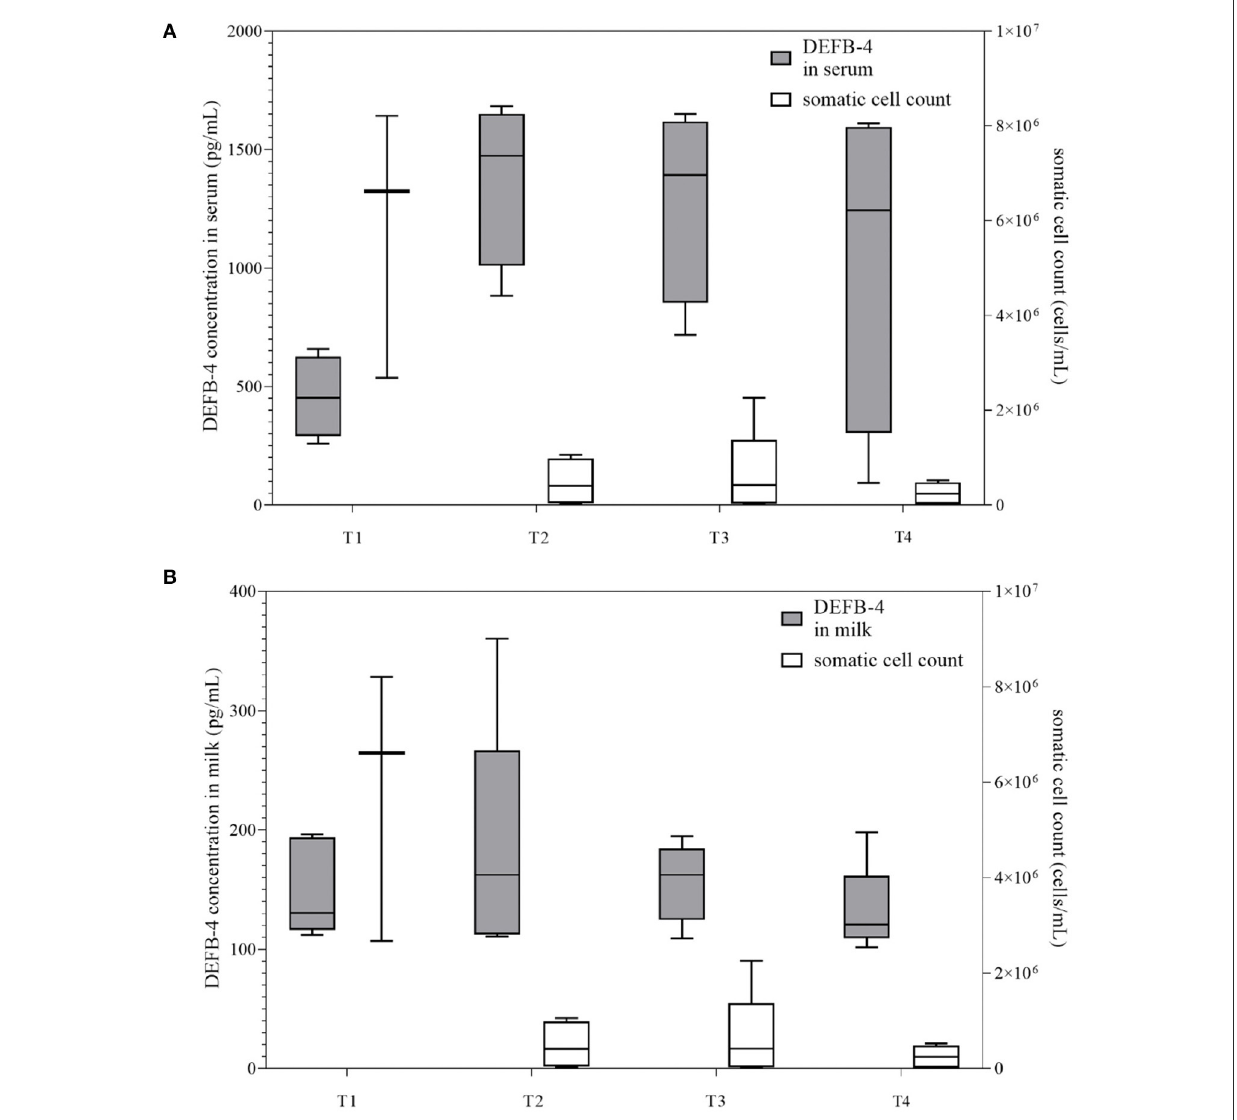
FIGURE4 DEFB-4 concentrations of the time kinetics study grouped with the somatic cell count which is currently the standard parameter for the detection of mastitis. Four cows with acute clinical mastitis were sampled directly after the appearance of clinical symptoms and again after 3, 5, and 7 weeks. T1 marks the initial time of sampling. T2, T3, and T4 mark the time of sampling after 3, 5, and 7 weeks. (A) demonstrates DEFB-4 concentrations in serum and (B) shows DEFB-4 concentrations in